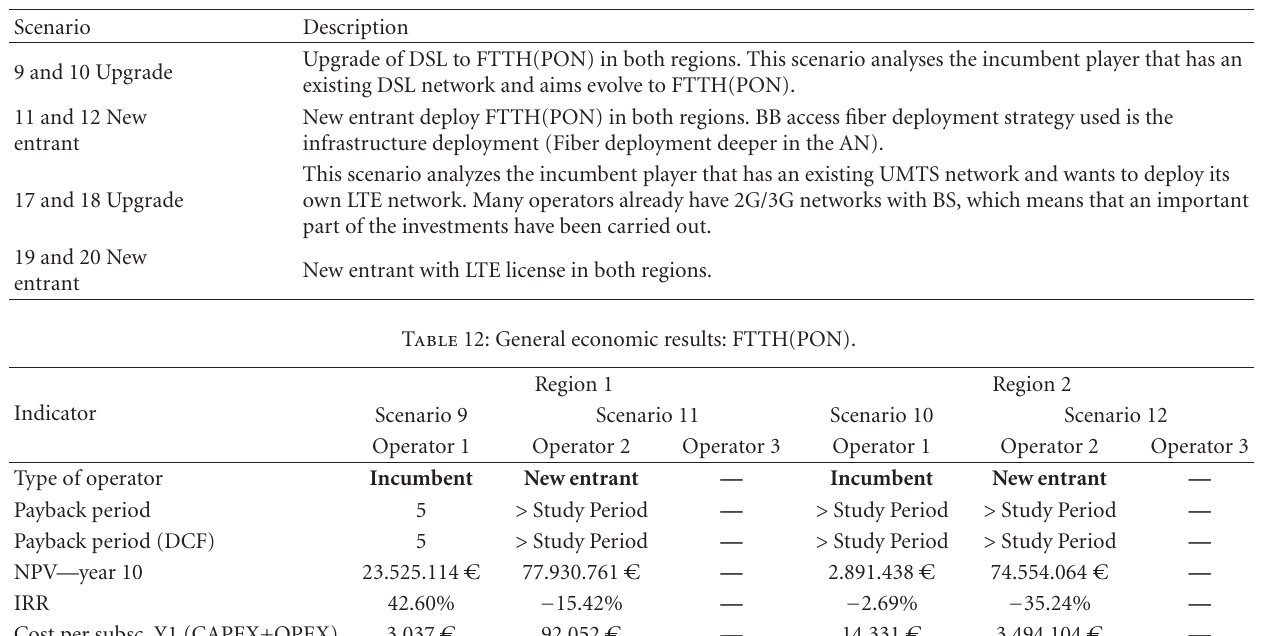
Table 11: Scenarios description.